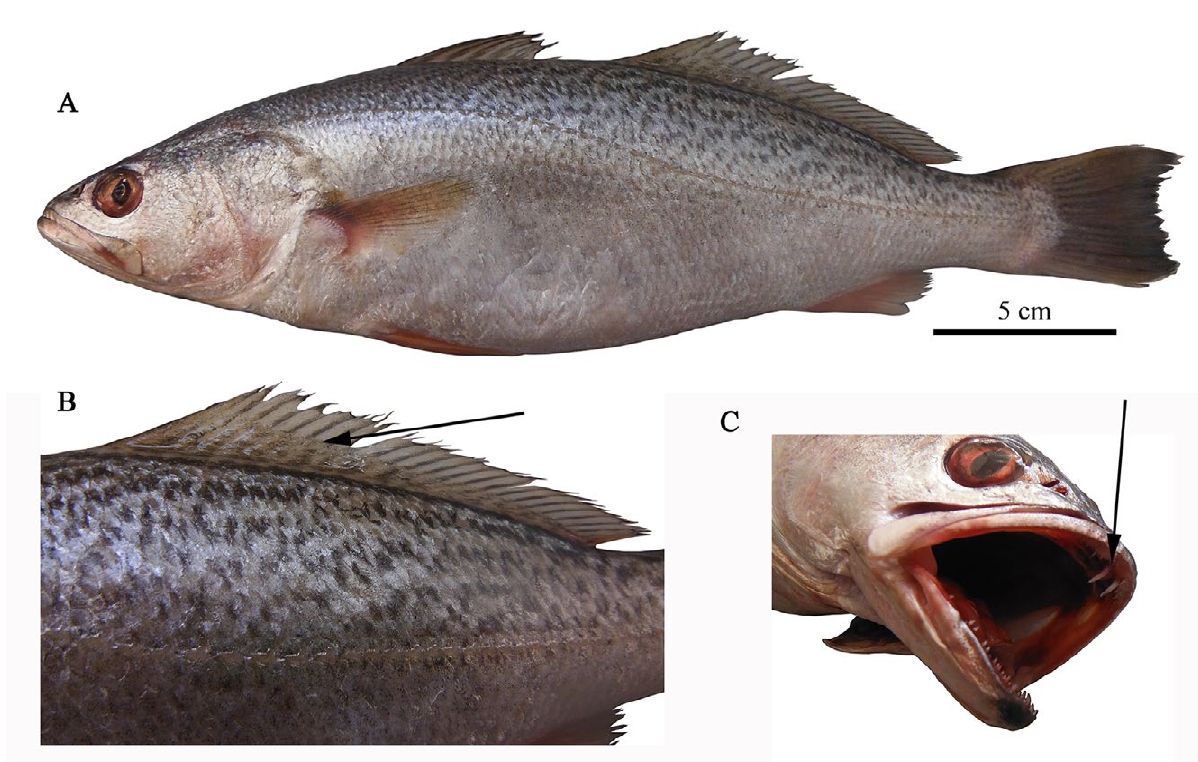
Fig. 1. – Specimen of C. regalis . A, view of an entire specimen of 313 mm TL; B, detail of scales at the base of soft dorsal fin; C, detail of the two large canine-like teeth in the upper jaw. The arrows indicate the position of the described